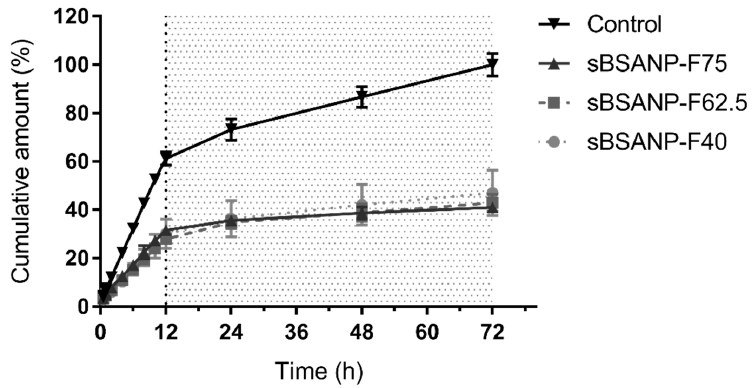
Figure 4. The release profiles of the SN-38 control group and SN-38-loaded sBSANPs with different BSA concentrations at 75, 62.5, and 40 mg/mL of BSA.